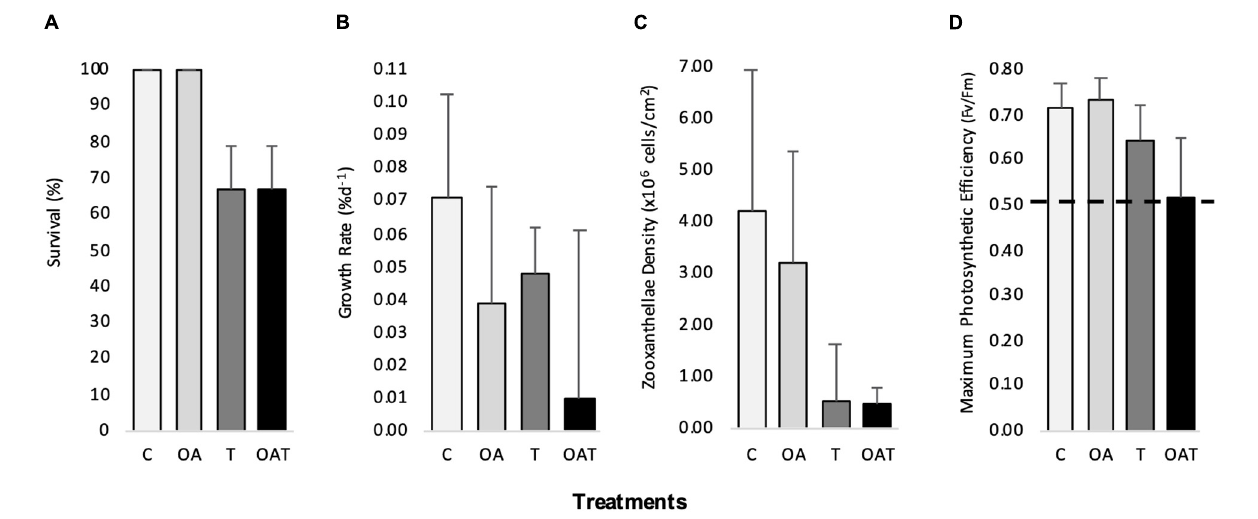
FIGURE 3 | Physiological response (mean ± SD) of Favites colemani after 28 days exposure to pH-temperature stress. (A) survival (B) growth rate (C) zooxanthellae density (D) maximum photosynthetic efficiency (values above horizontal dashed line mean photosynthetically competent). ( n = 15 for survival in OA, T, OAT; n = 15 for growth rate, zooanthellae density, maximum photosynthetic efficiency in C, OA, and n = 10 in T, OAT).